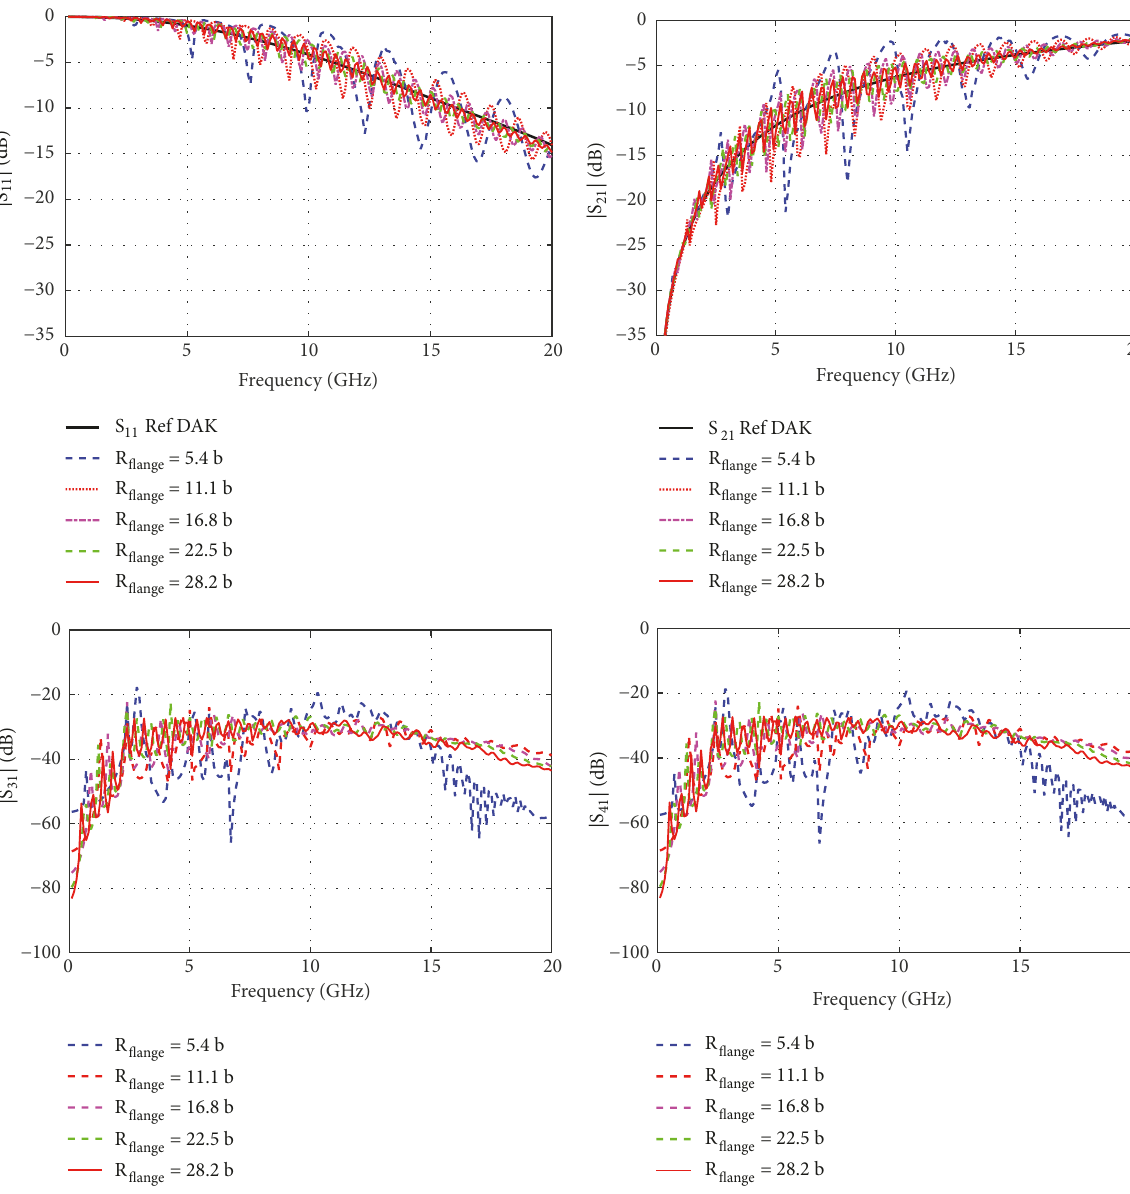
modes at the input/output coaxial lines, for different values of the n